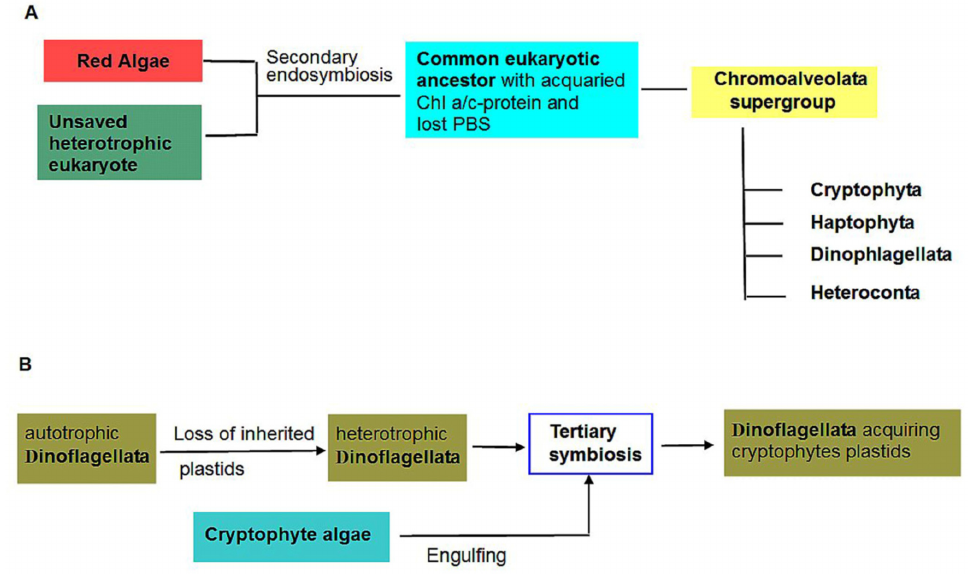
Figure 4. Schemes of secondary and tertiary endosymbioses. ( A ) Red line of secondary endosym- biosis, leading to a branched group of Chromoalveolata, including cryptophyte algae. ( B ) Tertiary endosymbiosis with the demonstration of replacement Dinoflagellata chromoplasts by plastids of engulfing cryptophyte alga.